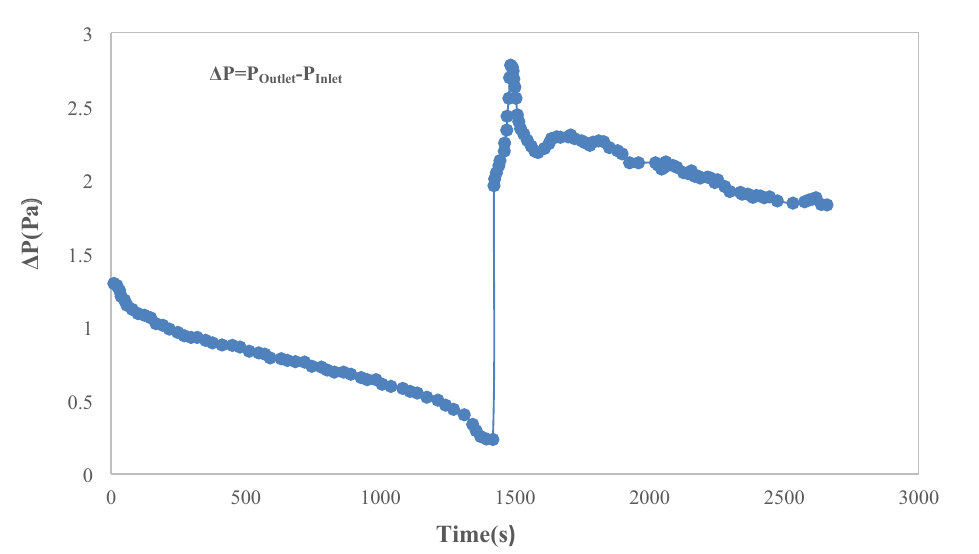
Figure 12. Pressure variations for the whole process of hydrogel injection.